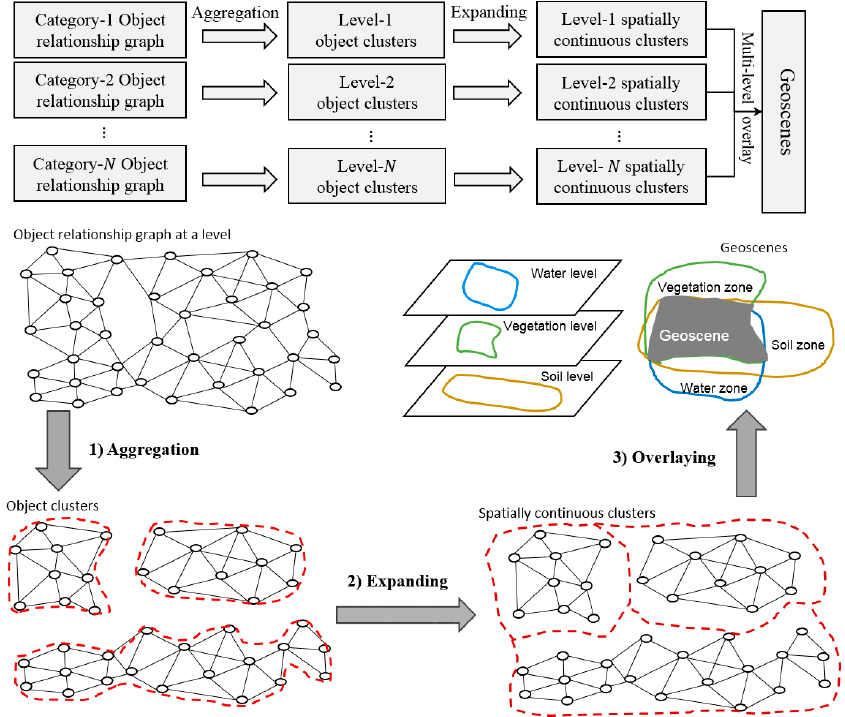
Figure 7. Procedure of geoscene segmentation including three steps: (1) aggregation; (2) expanding; and (3) overlaying.